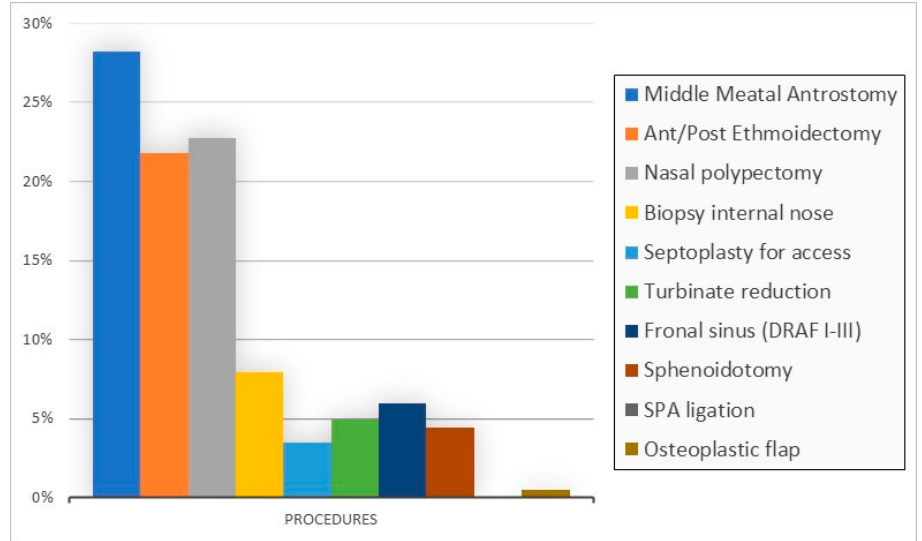
Figure 3. Sinonasal procedure performed by OPCS-S coding.